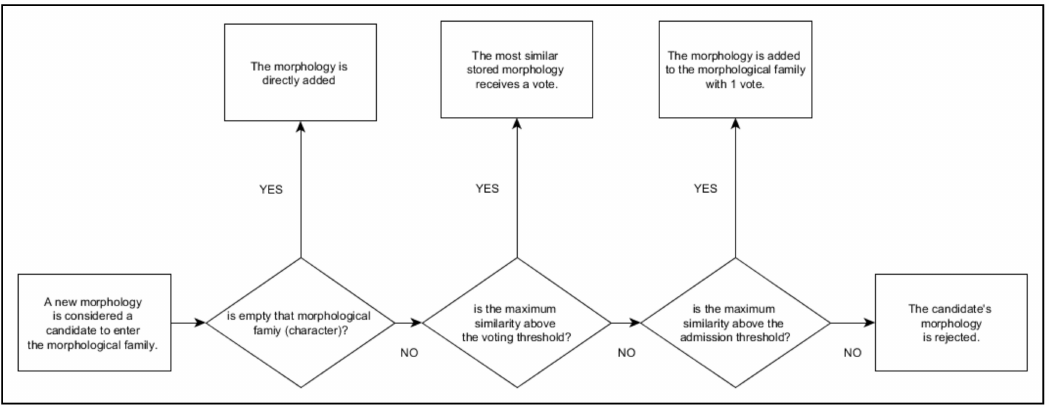
Figure 12. Flow diagram showing how the di ff erent tests are applied to decide the fate of a morphology. For the time being, the three thresholds—vote threshold, admission threshold and purge threshold—are selected through a trial and error procedure. The vote and admission thresholds are values between 0 and